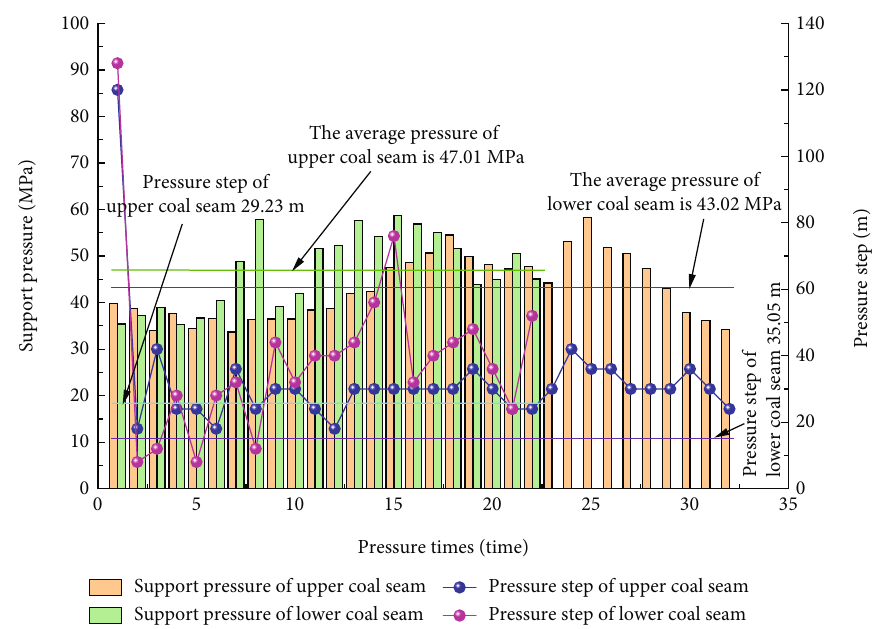
Figure 20: Periodic compression of mining coal seam groups at a close